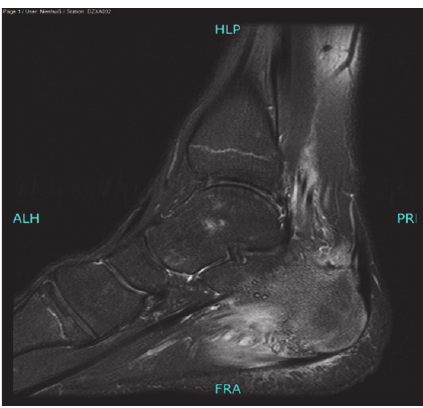
Figure 3: MRI T1: sagittal view of the left foot: enthesophyte at the insertion of the plantar fascia.